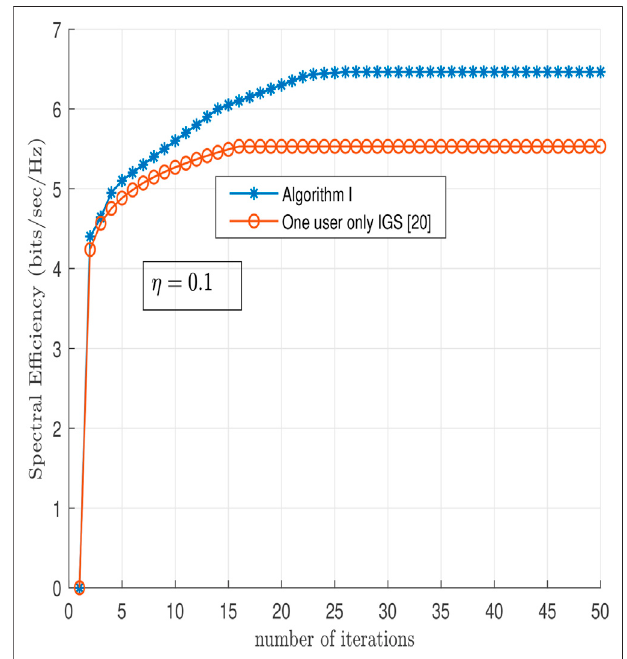
FIGURE 4 | Spectral ef fi ciency comparison between IGS-based and PGS-based (Abu Mahady et al., 2019) for various η = 0.1, 0.2, 0.3, 0.4, and fi xed α = 0.4.